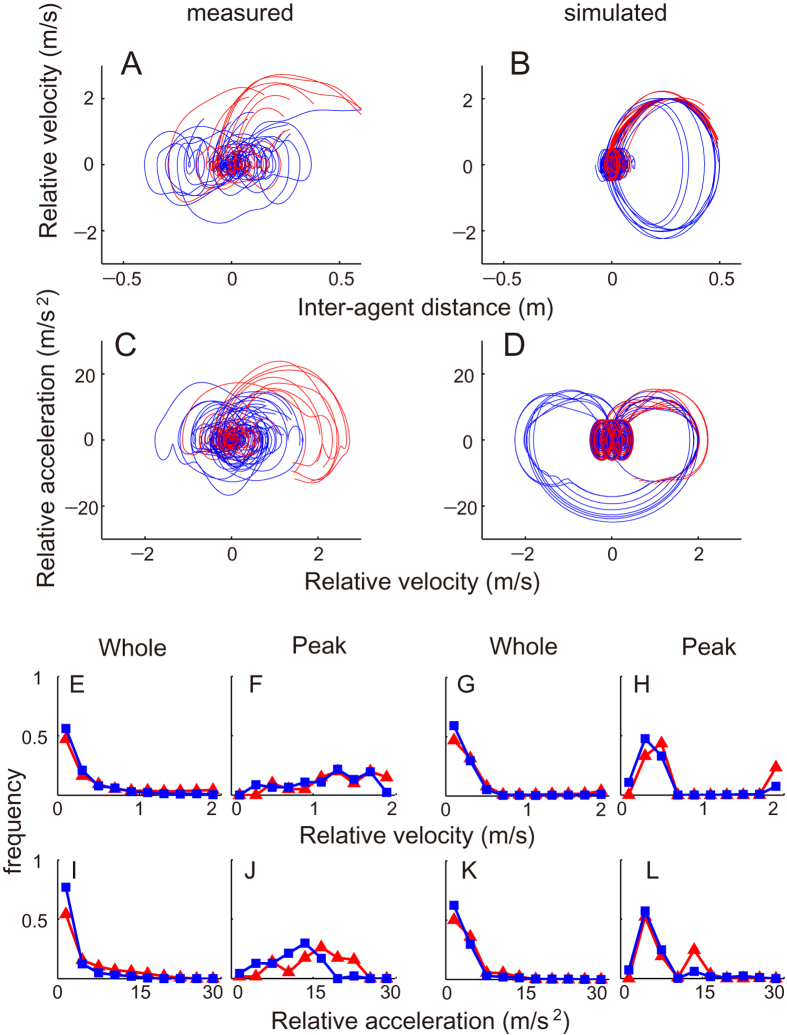
Phase portrait and histogram of order parameters in two-player system.Trajectory in the phase plane of interplayer distance (A,B) and velocity difference (C,D) in measured (A,C) and simulated (B,D) successful-attack (red) and successful-defence (blue) trials. In detail, normalised frequencies of velocity (E–H) and acceleration (I–L) difference in the determination phase in measured (E,F,I,J) and simulated (G,H,K,L) successful-attack (red) and successful-defence (blue) trials were presented. All data in Fig. 4E–L was submitted as Supplementary Dataset 3–6.